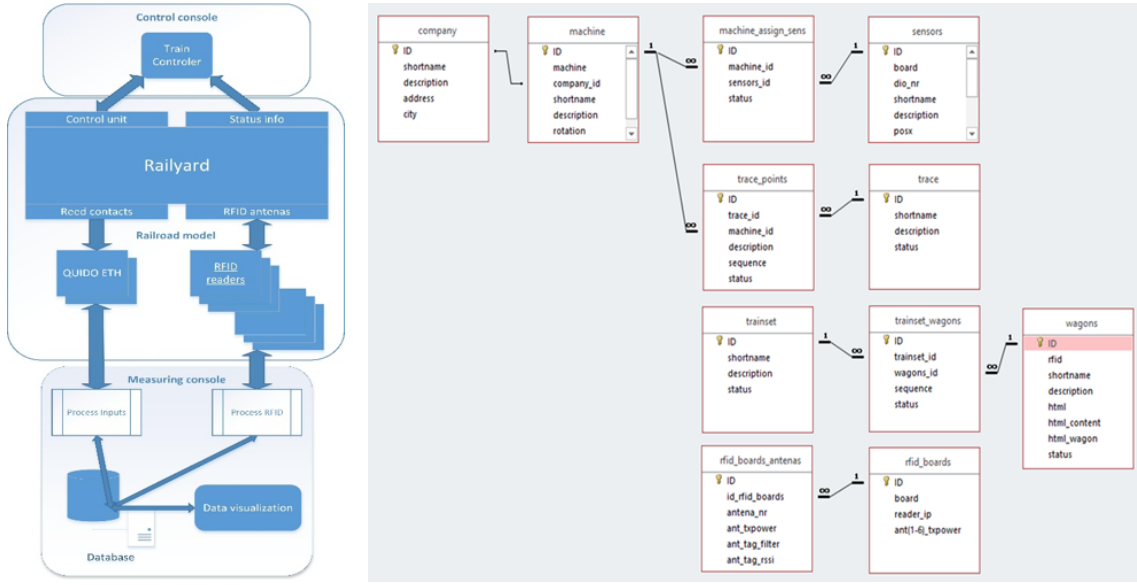
Figure 2: a: block structure of physical model; b: part of data structures (tables with relations)